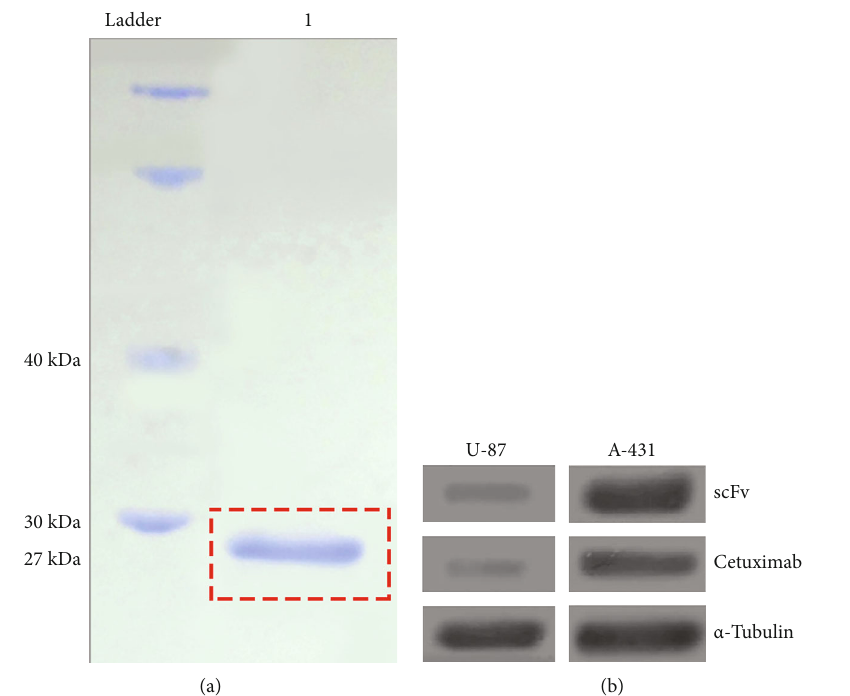
Figure 1: SDS-PAGE and western blotting results. (a) His-tag a ffi nity chromatography puri fi ed cet.Hum.scFv. Protein bands of the same molecular weight (27 kDa) appeared in 1 lane. (b) The results of western blotting with the antibodies and A-431 and U-87 MG cells. Alpha-tubulin was used as the loading control. Both cet.Hum.scFv and cetuximab are able to form thick protein bands of approximately 175kDa with A-431 cells, but not with U-87 MG cells.